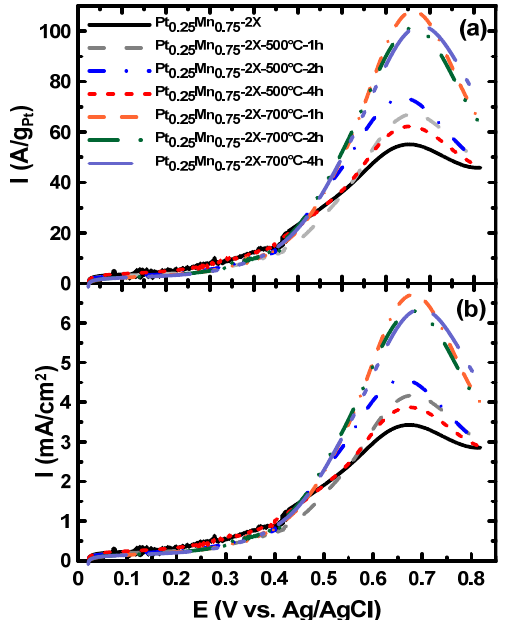
Figure 12. LSV of the samples prepared in the presence of sodium citrate and heat treated at 500 and 700 °C for different periods, in the 0.5 M H 2 SO 4 + 0.1 M ethanol solution at a scan rate of 20